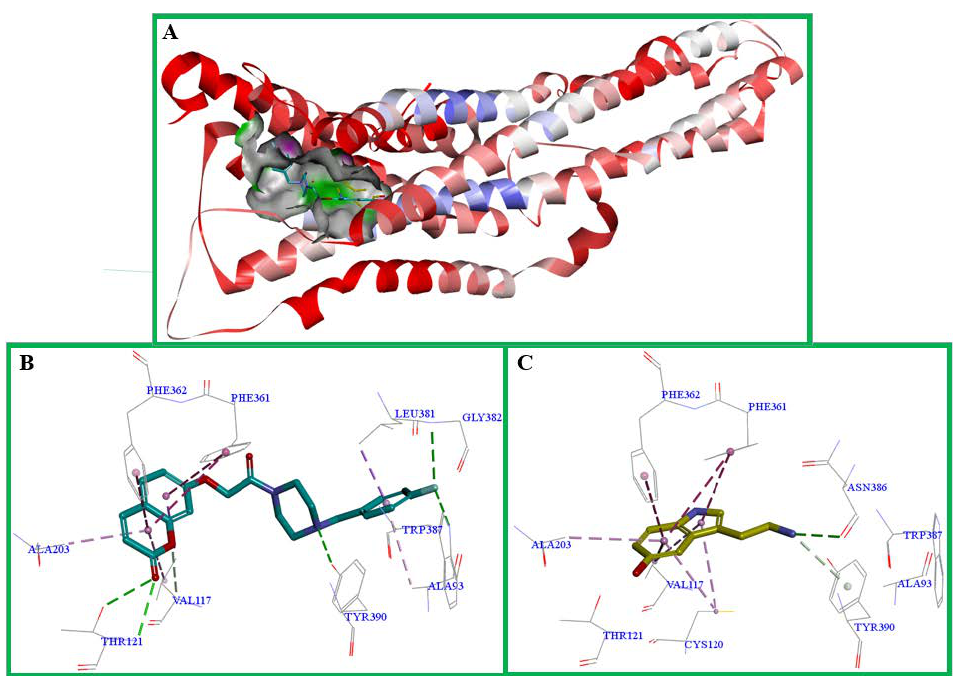
Figure 7. ( A ) Binding pocket of compound 6i and serotonin to the 5-HT 1A receptor—homology model; ( B ) compound 6i shows interactions with residues at the 5-HT 1A receptor. ( C ) Serotonin shows interactions with residues at the 5-HT 1A receptor.